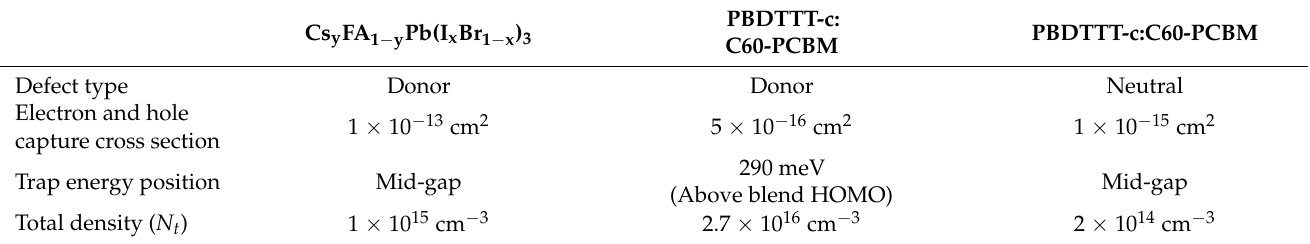
Table 2. Bulk defects parameters in the perovskite and organic layers